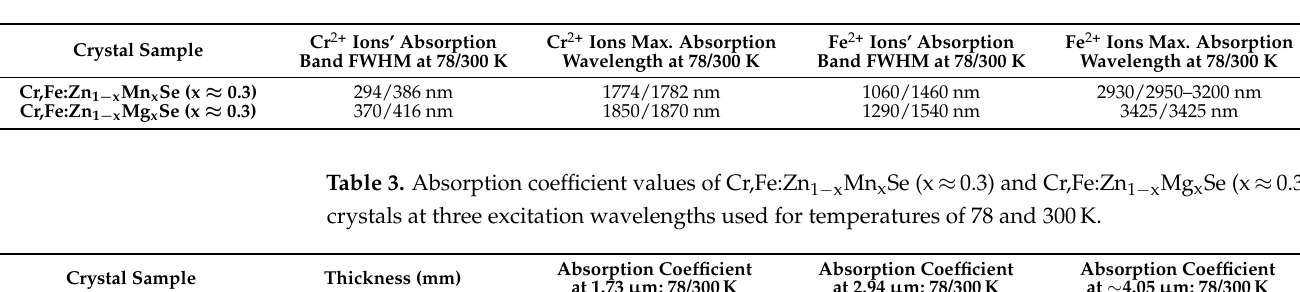
Table 2. Absorption spectra properties of Cr,Fe:Zn 1 − x Mn x Se (x ≈ 0.3) and Cr,Fe:Zn 1 − x Mg x Se (x ≈ 0.3) crystals at 78 and 300 K.